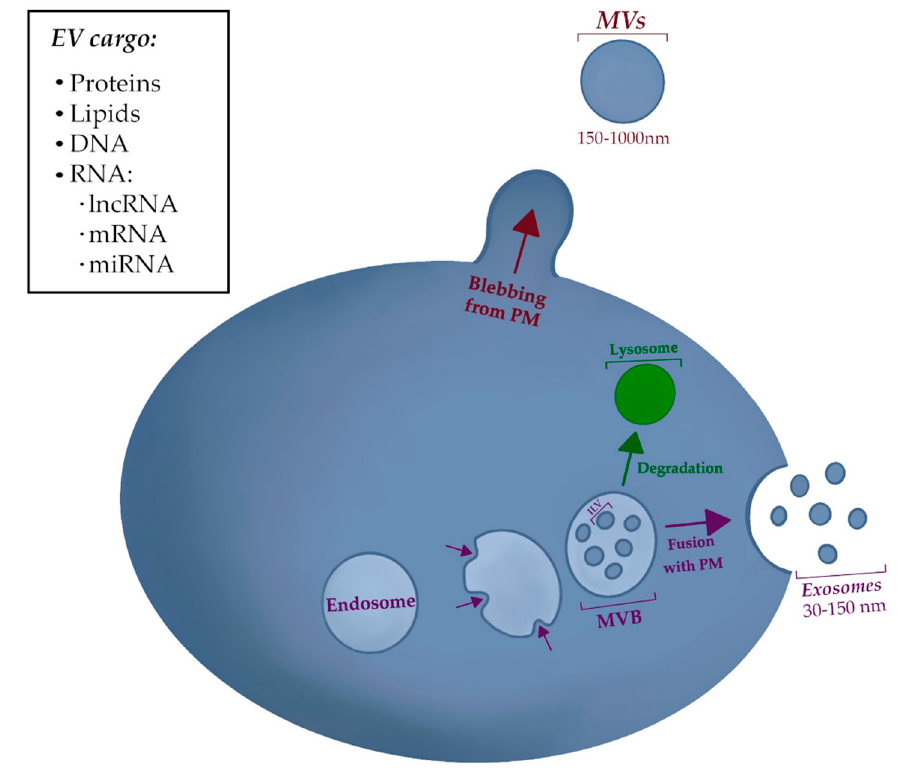
Figure 1. Schematic representation of microvesicles (MVs) and exosomes’ biogenesis and release by eukaryotic cells. MVs are formed after an outward blebbing of the plasma membrane (PM) and are usually sized between 150 and 1000 nm. Exosome (30–150 nm) formation begins in late endosomes that maturate into multivesicular bodies (MVB), including the formation of intervesicular bodies (ILVs) through the inward budding of the MVs limiting membrane. MVB can fuse with the plasma membrane and release the ILVs into the extracellular space as exosomes. Alternatively, MVB can suffer degradation by fusing with lysosomes. EVs can contain numerous biomolecules, including protein, lipids, DNA, and RNA.